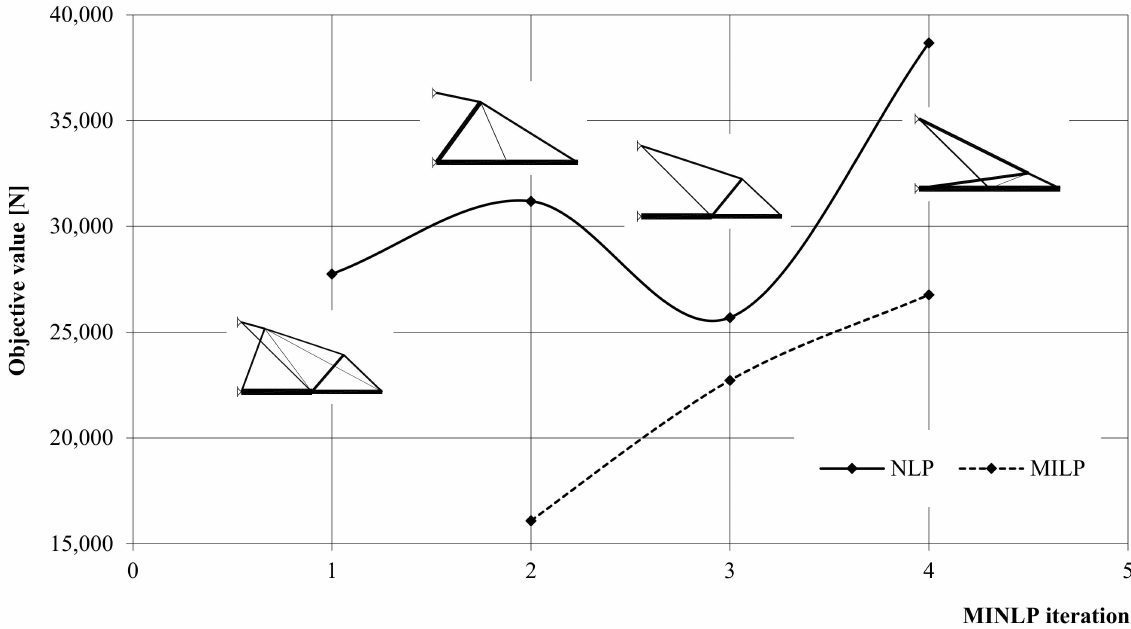
Figure A2. Convergence to the optimal topology (initial MINLP phase of the MTP strategy), example TC10d (topology and shape optimization, with buckling